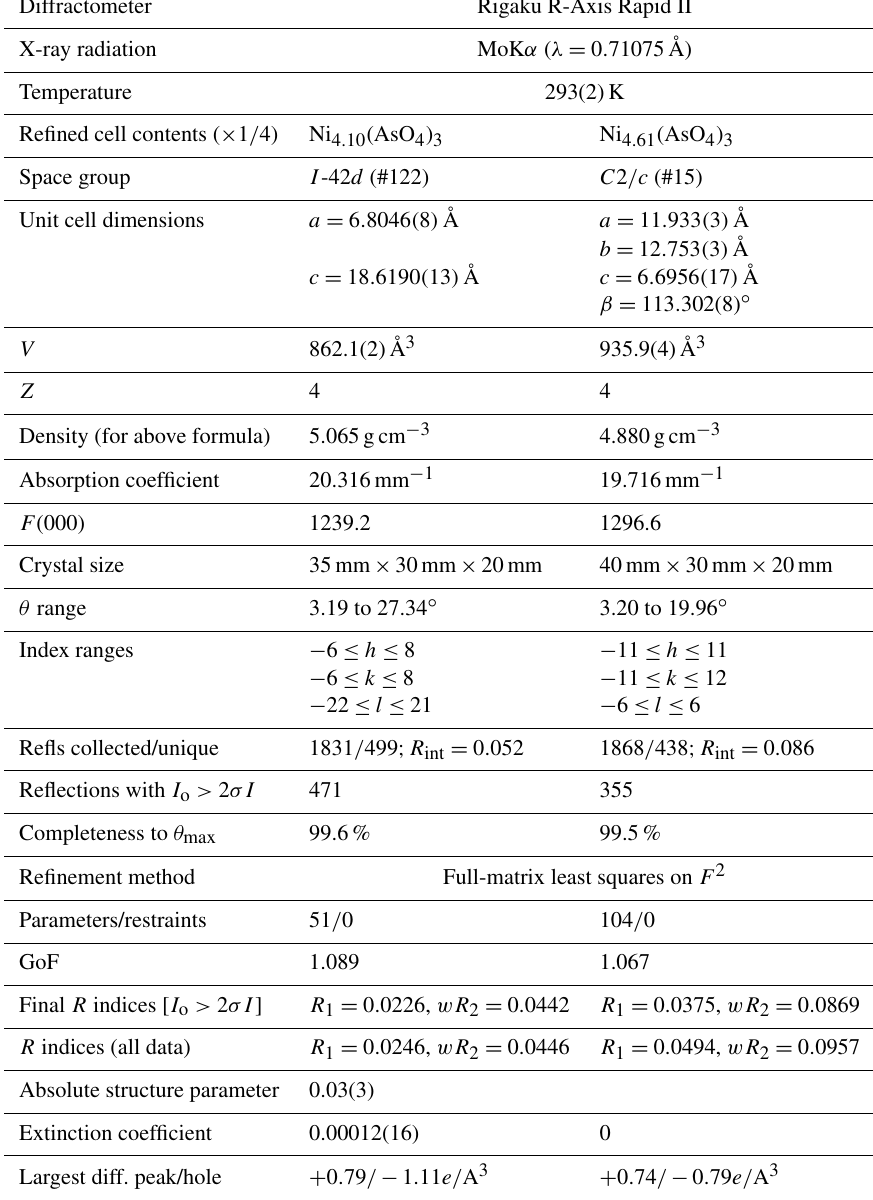
Table 3. Data collection and refinement conditions for niasite and johanngeorgenstadtite.